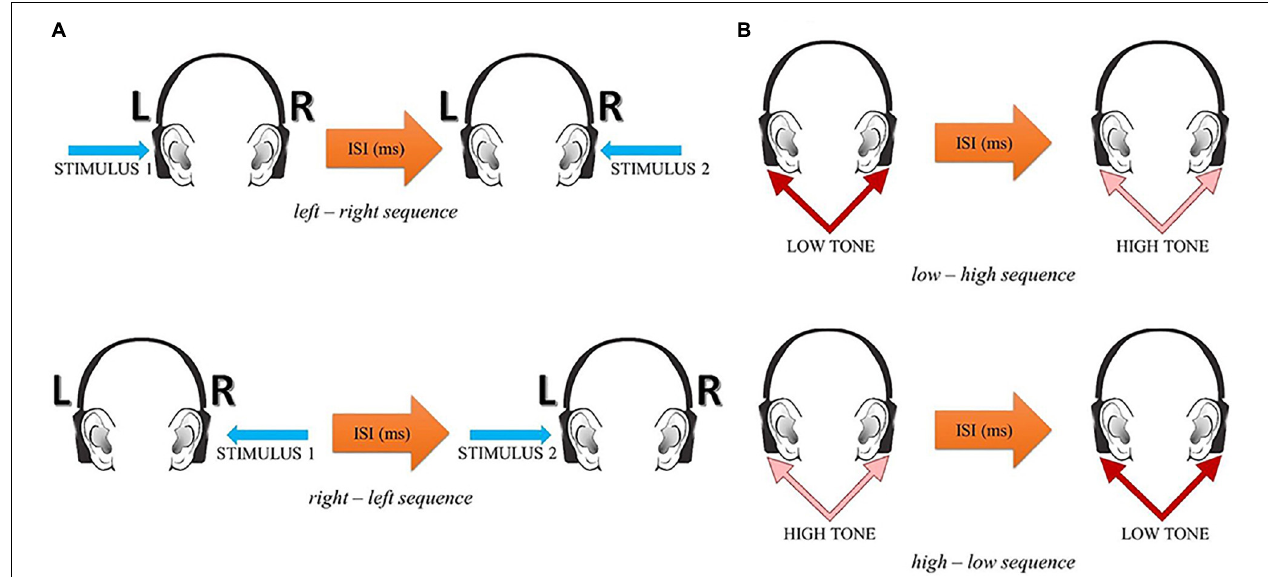
FIGURE 1 | The experimental situation in the spatial (A) and spectral (B) temporal-order judgment tasks (reprinted from Szelag et al., 2018, p.